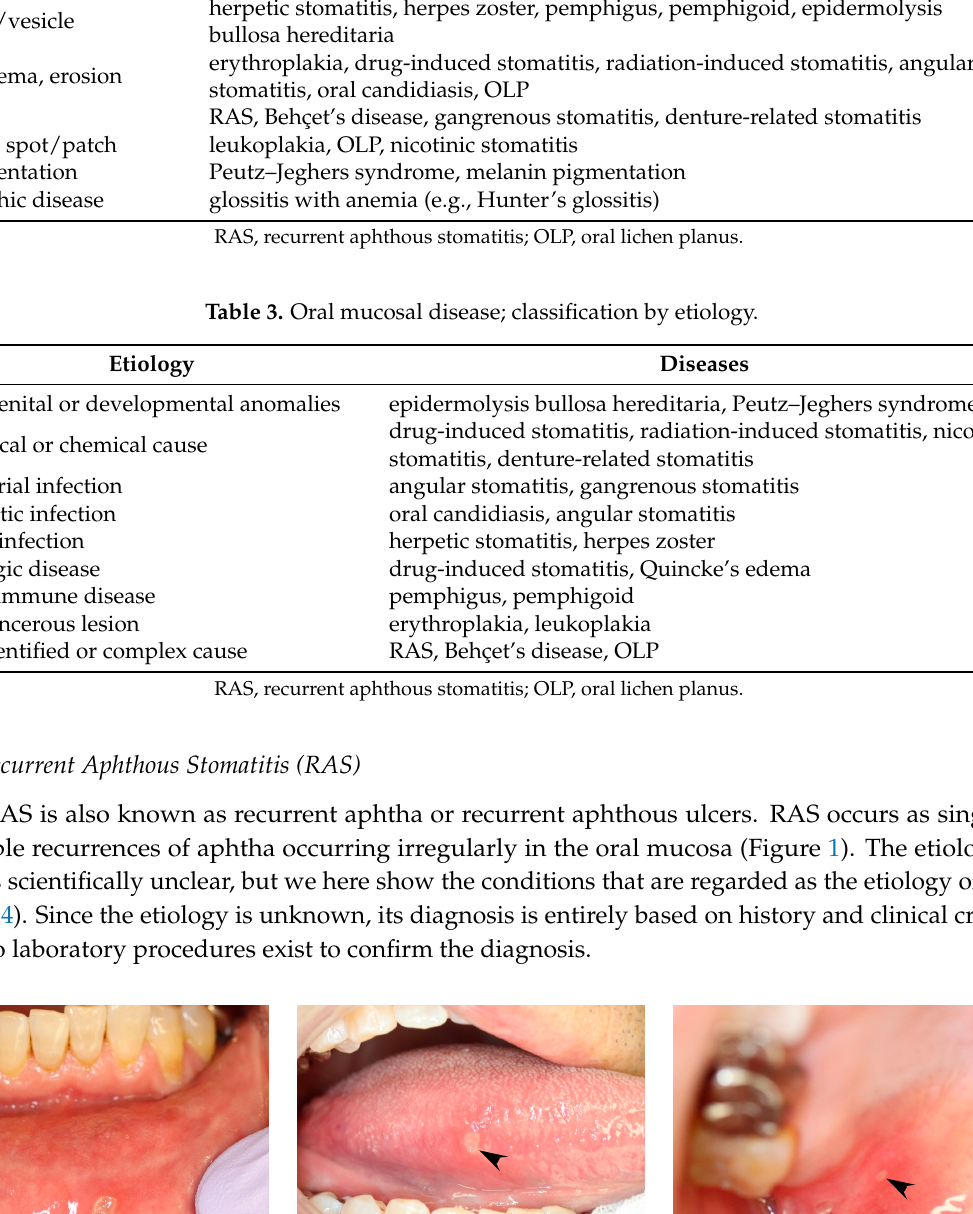
Table 2. Oral mucosal disease; classification by clinical manifestations.